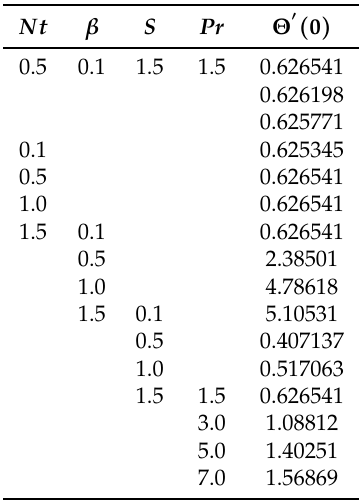
Table 1. Variation in Nusselt number with different values of the parameters Nt , Pr , β , and S . Nt